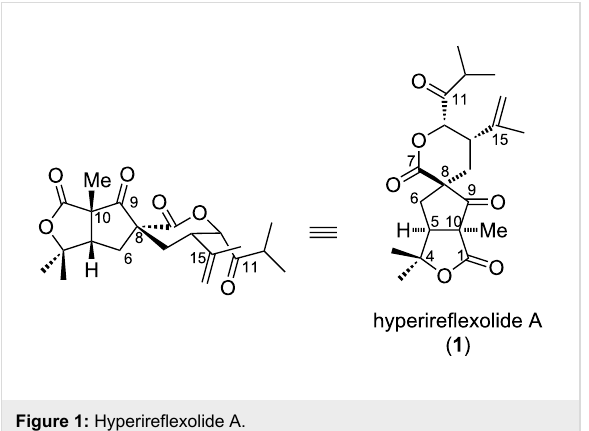
Figure 1: Hyperireflexolide A.